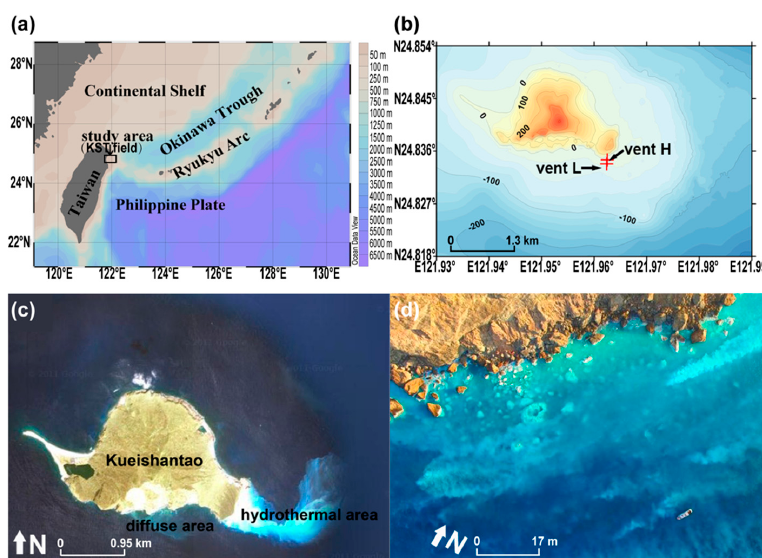
Figure 1. Geological setting of the Kueishantao hydrothermal field. ( a ) Geological setting of Kueishantao (KST) area at the southwest end of the Okinawa Trough. Box outlined in black is area given in (b); ( b ) Bathymetric map of KST field. The red “+” symbols show the positions of the white vent and yellow vent, respectively; ( c ) Satellite image of Kueishantao island and the KST hydrothermal field with diffuse and focused fluid areas; ( d ) Aerial view of the KST sampling area (note ship in the lower right corner; courtesy of M. Lebrato).